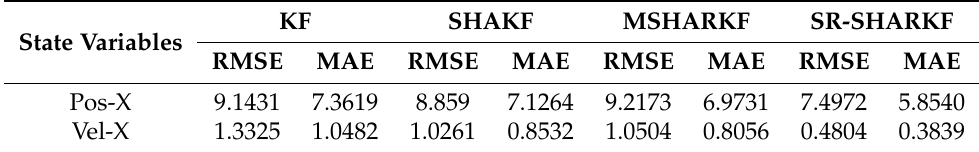
Figure 15. Dynamic parameter error. ( a ) Position error in the X-axis direction. ( b ) Velocity error in the X-axis direction. ( c ) Position error in the Y-axis direction. ( d ) Velocity error in the Y-axis direction. Table 7. Dynamic parameter error evaluation in the X-axis direction.